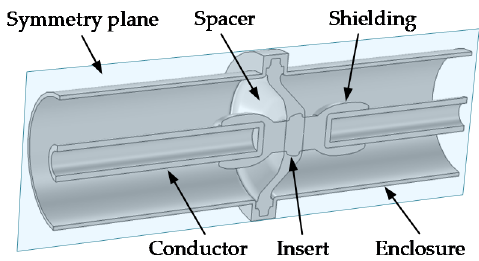
Figure 1. Geometric model of the GIL model. Table 1. Parameters of the simulation model.